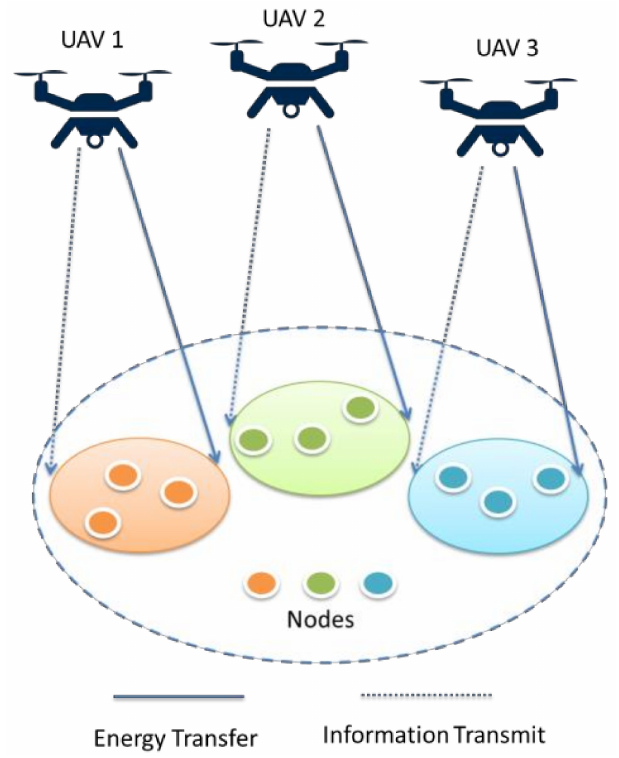
Figure 15. Multi-UAV-enabled SWIPT